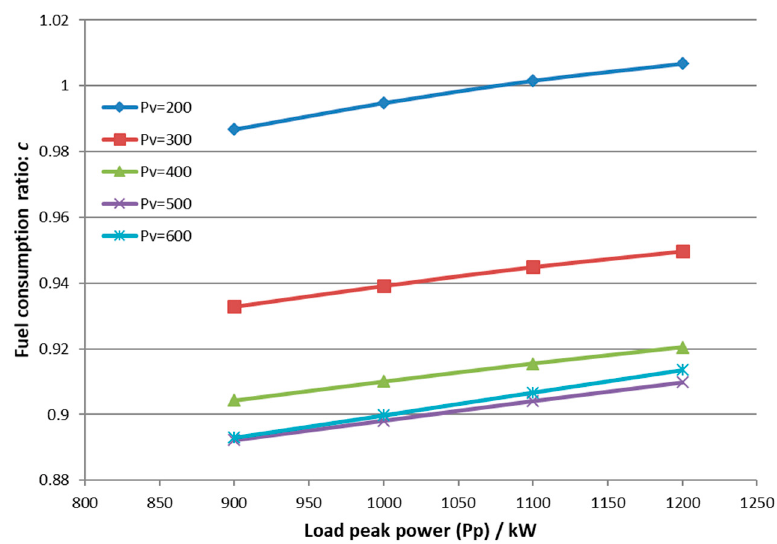
Figure 10. Fuel consumption ratio comparison ( t = 5 , η = 0.85 , r = r t ).